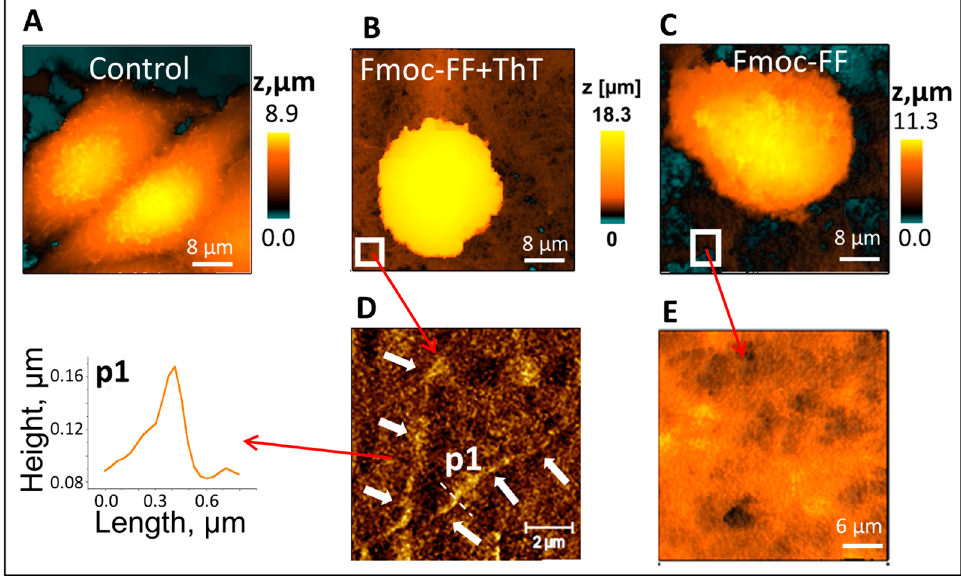
Figure 2. SICM topography imaging of the hydrogels and living cells grown on them. ( A – C ) The topography of living cells (MCF-7) grown on ( A ) control substrate, ( B ) Fmoc-FF+ThT hydrogel, ( C ) Fmoc-FF hydrogel. ( D , E ) The topography of ( D ) Fmoc-FF+ThT and ( E ) Fmoc-FF hydrogel. In the insert of figure ( D ), an image of a single fibril is shown. White arrows show single fibrils topography of the Fmoc-FF+ThT system. Concentrations: Fmoc-FF = 5 mg/mL, ThT = 40 µM.